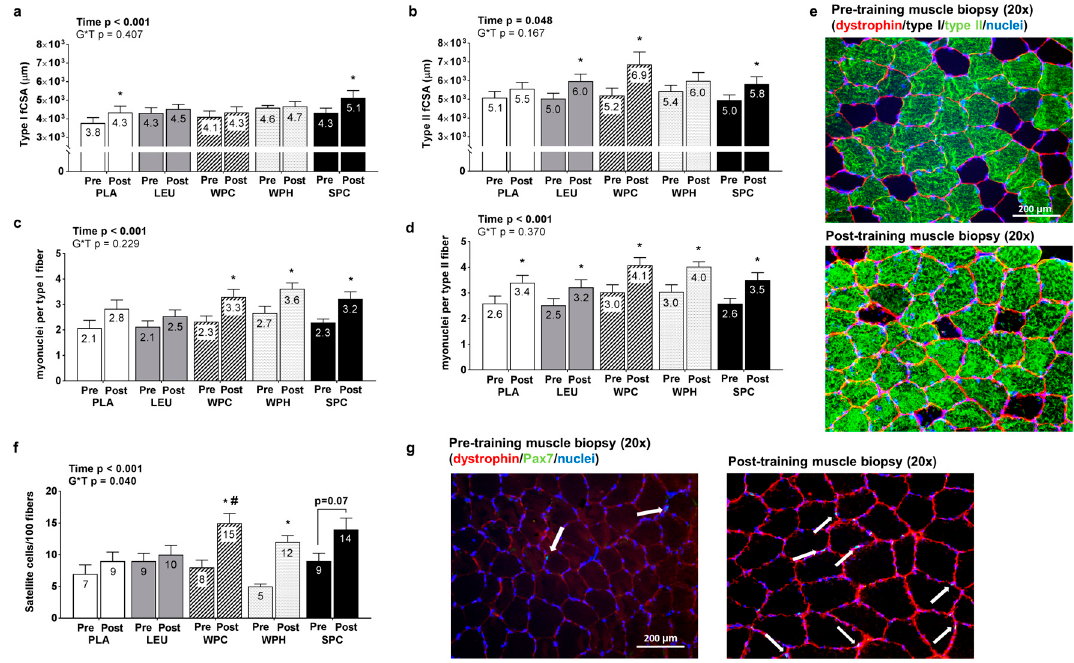
Figure 5. Changes in muscle fiber cross sectional area, myonuclear number and satellite cell counts between groups. Legend: Data include pre- and post-intervention type I and type II fiber cross sectional area (CSA) values ( panels a , b ), type I and type II fiber myonuclear number values ( panels c , d ), and total satellite cell counts ( panel f ). Due to poor tissue quality on select subjects, n-sizes were as follows: PLA n = 13, LEU n = 13, WPC n = 15, WPH n = 12, and SPC n = 14. Representative 20 × objective histology images from one subject demonstrating myofiber hypertrophy and increases in satellite cell counts are presented in ( panels e , g ), respectively. Each bar graph depicts group averaged data presented as mean + standard error values, and mean values are presented within each bar. Abbreviations: PLA, maltodextrin placebo; LEU, L-leucine; WPC, whey protein concentrate; WPH, whey protein hydrolysate; SPC, soy protein concentrate. Symbols: * within-group increase from pre- to post training ( p < 0.05); #, WPC > PLA at T39 ( p < 0.05).